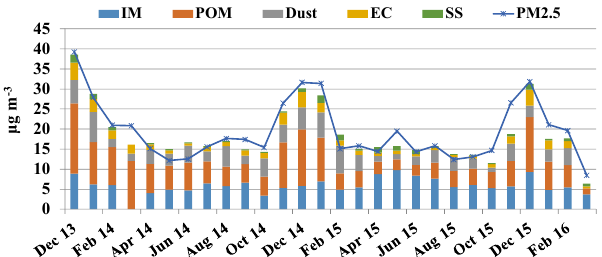
Figure 3. Annual seasonal chemical mass closure of each aerosol species for PM 2 . 5 samples collected at Thissio for the studied pe-